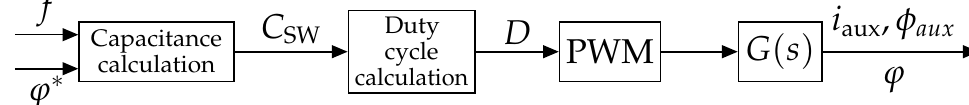
Figure 13. A simplified block diagram of the open-loop control of current phase advancing.